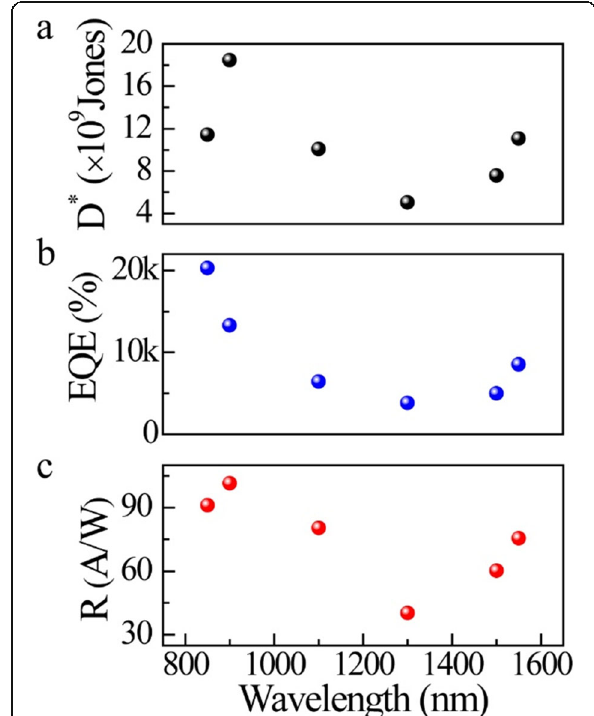
Fig. 3 NIR photoelectric performance of multilayer Bi 2 O 2 Se – based photodetector. a Photoresponsivity, b external quantum efficiency, and c detectivity as a function of NIR